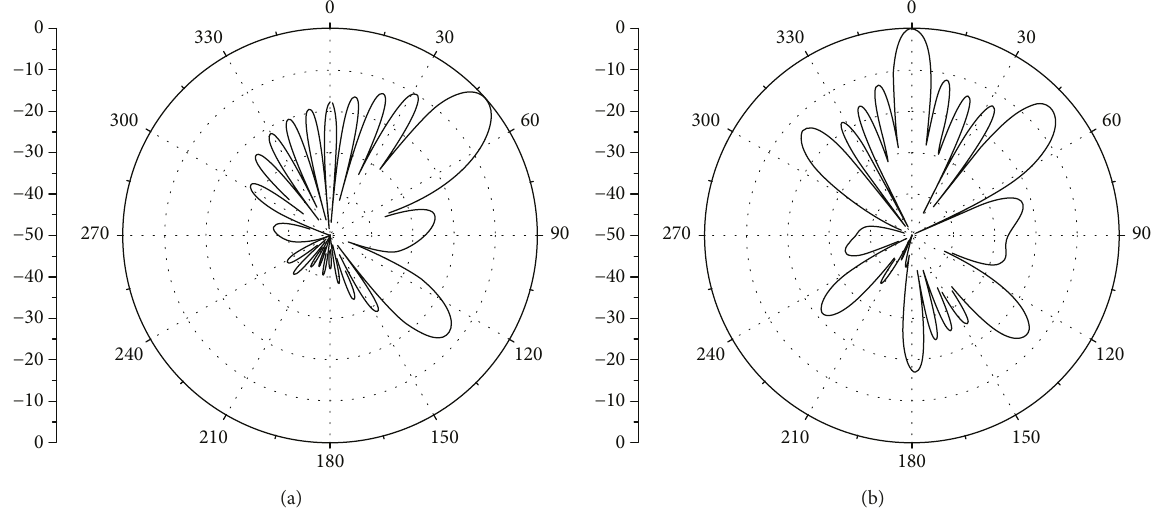
Figure 8: Calculated radiation pattern for (a) Con fi guration 1 and (b) Con fi guration 2.